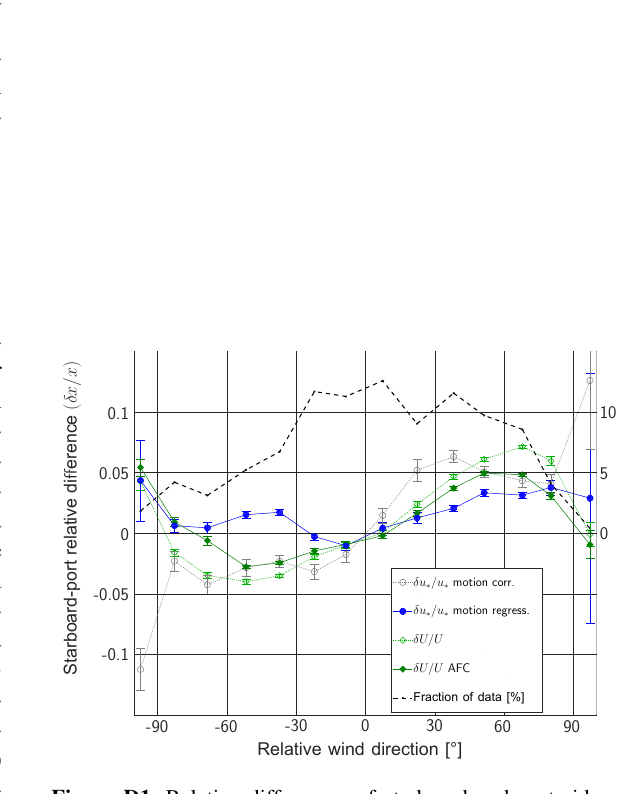
Figure D1. Relative differences of starboard and port side mea- surements of u ∗ and wind speed as a function of the relative wind direction calculated as (stbd–port) / (stbd + port) and averaged over 15 ◦ wind direction bins. The plot shows δu ∗ / (cid:104) u ∗ (cid:105) for only motion- and tilt-corrected wind speeds (grey dashed open circles) and with all regression corrections applied (blue filled circles), respectively. The relative differences of the wind-speed measurements, with and without airflow distortion correction applied, are shown as open and filled green diamonds, respectively. The black dashed line indicates the fraction of data observed in each wind direction sector. The error bars show the standard error of the mean